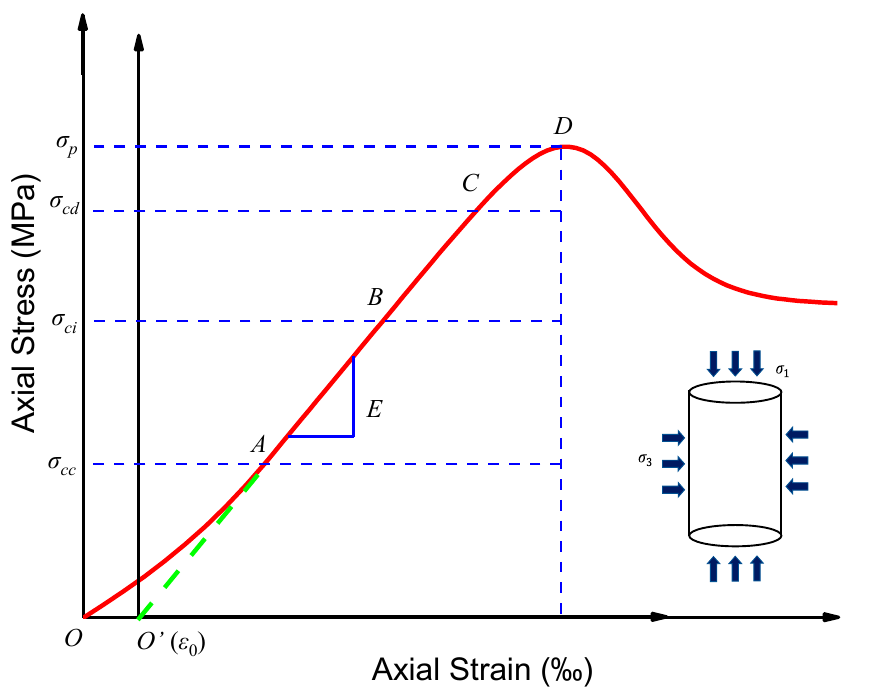
Figure 7. Stress–strain curve for the new coordinate system. If the rock material is divided into n units of equal area including damaged units and undamaged units only, then the damage variable D can be rewritten as Equation (14).